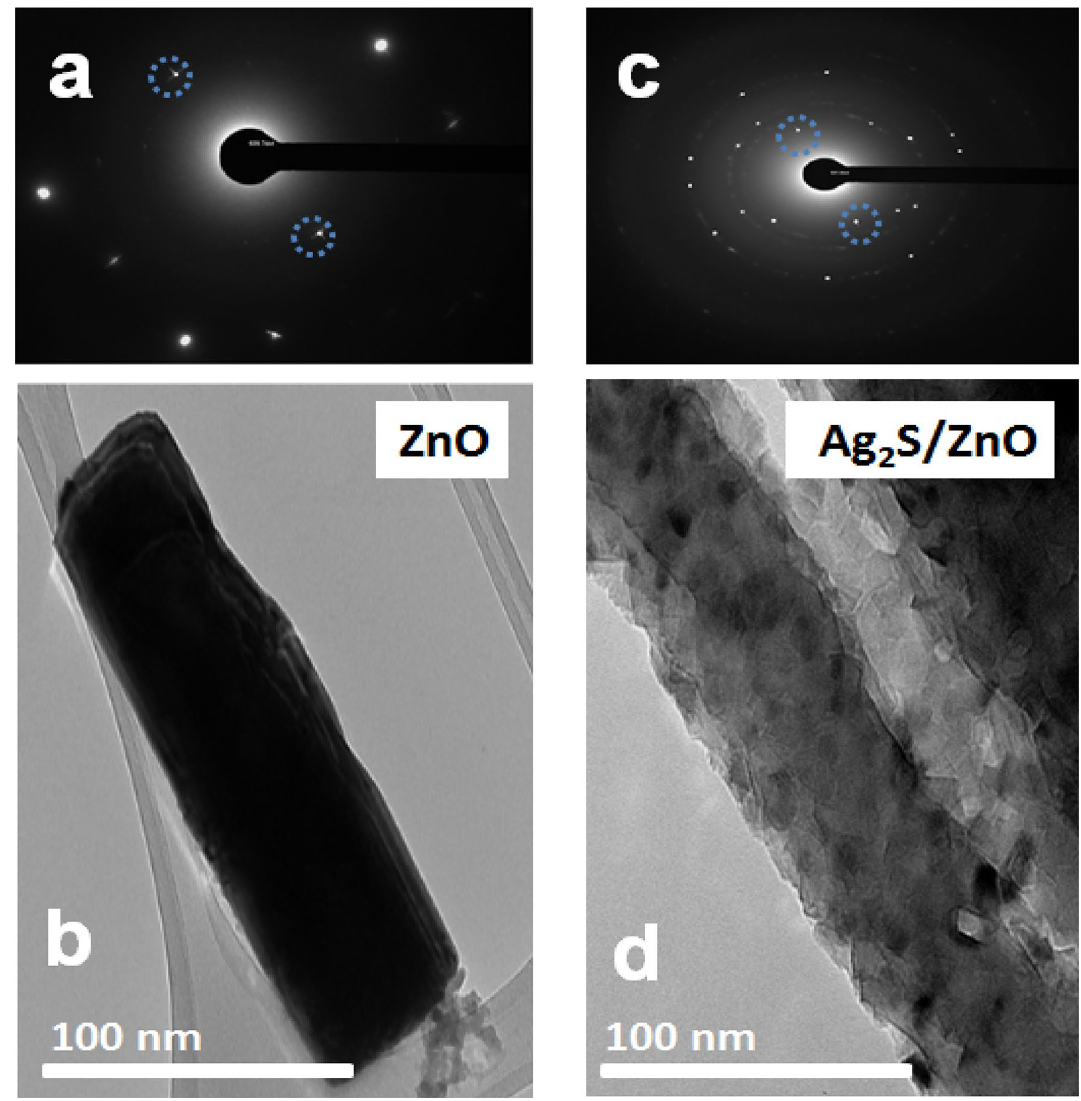
Figure 5. The TEM images and the SAED pattern of pure ZnO; ( a , b ) and Ag 2 S/ZnO ( c , d